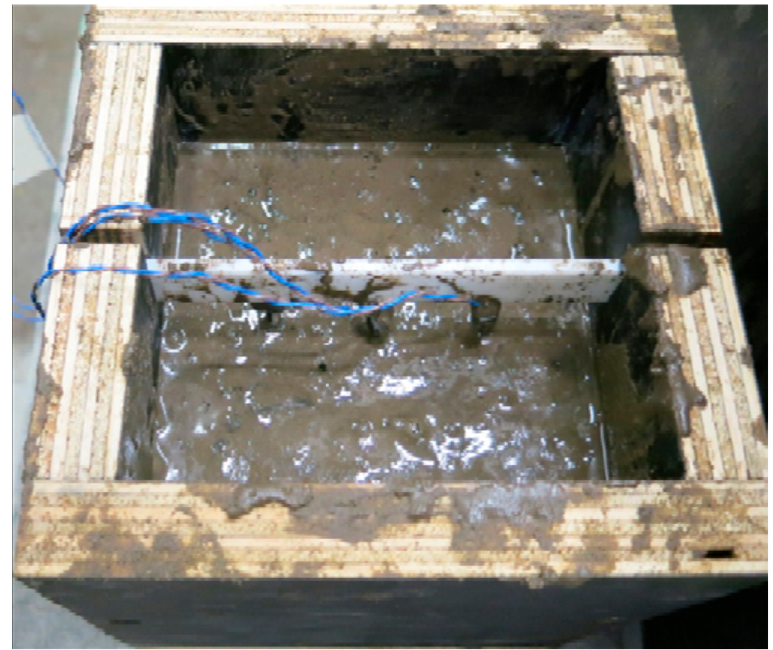
Figure 1. The concrete specimen (100 mm cube) with thermocouples embedded.